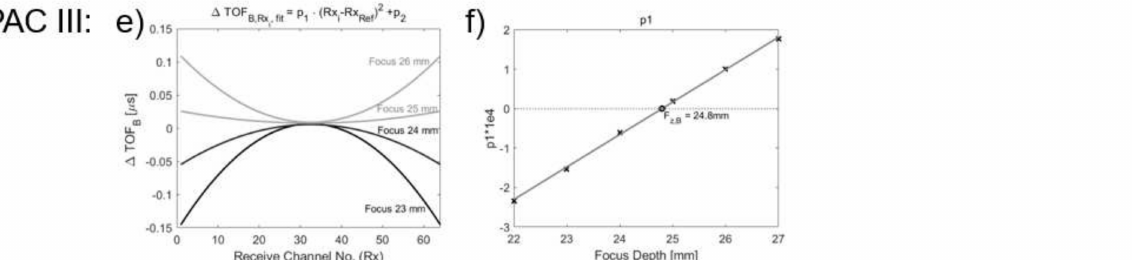
Figure A3. PAC I: ( a ) Schematic illustration of the additional shift ∆ TOF geo (red line) of a wave traveling from element 1 to focus F and back to element 64 for a curved shaped bone surface compared with a flat bone plate. Note, that a focused beam of 64 elements was used and only the propagation path of the ultrasound wave of one receiving channel is shown. PAC II: Details of 2D ACF analysis for model r40dx3 . 11. ( b ) Two-dimensional image of the gated backside signals at confocal depth (25 mm) after PAC I. ( c ) Two-dimensional magnitude of ACF backside signal. The fitted ellipsoid is shown in red. ( d ) Two-dimensional magnitude of ACF backside signal after the ACF correction. PAC III: Schematic illustration to estimate ∆ F z , B using cross-correlation for the flat plate model. ( e ) Second order fit from ∆ TOF B of the backside signals using cross-correlation. ( f ) Curvature parameter of the second order fit p 1 (black crosses) over the focus depth and the linear fit (grey line) to estimate the zero-crossing point (black circle) for the estimation of ∆ F z , B .